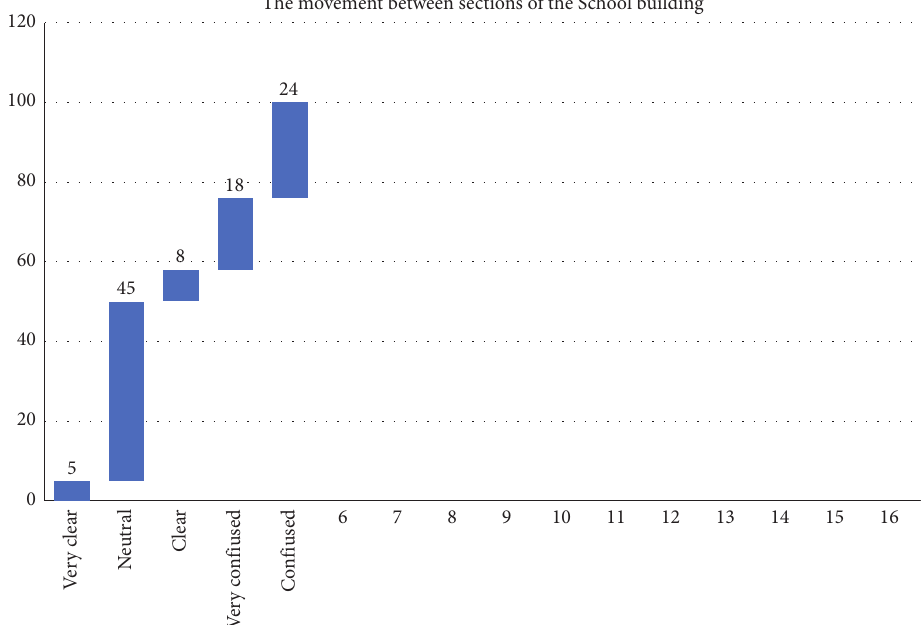
Figure 4: Moving between the building section to create an integration between outside spaces and inside.